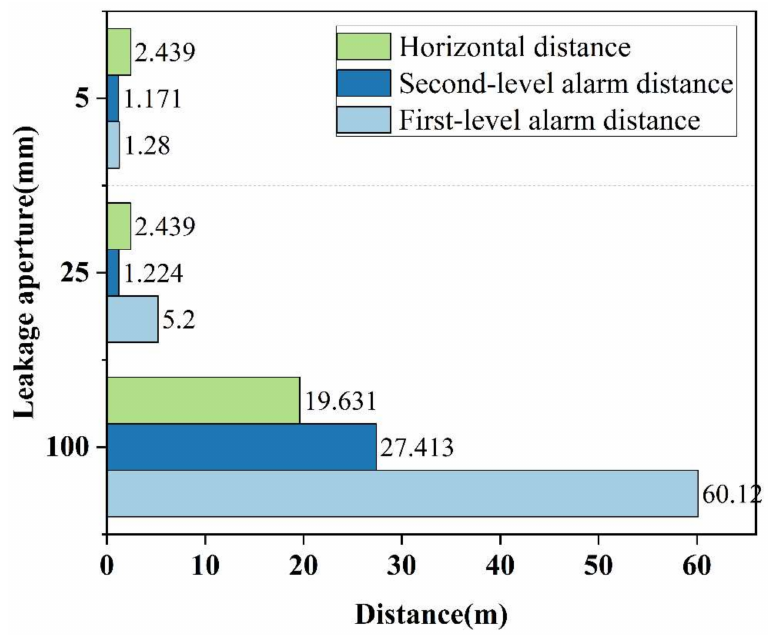
Figure 3. The relationship between the farthest alarm distance of combustible gas and leakage aperture.